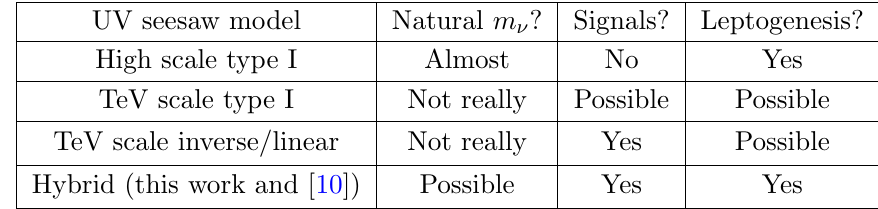
Table 1 . Our comparison of various UV completions of eq. (1.1): see explanation in text. is not fully understood. In view of our de(cid:12)nitions above, we may view such a scale as almost